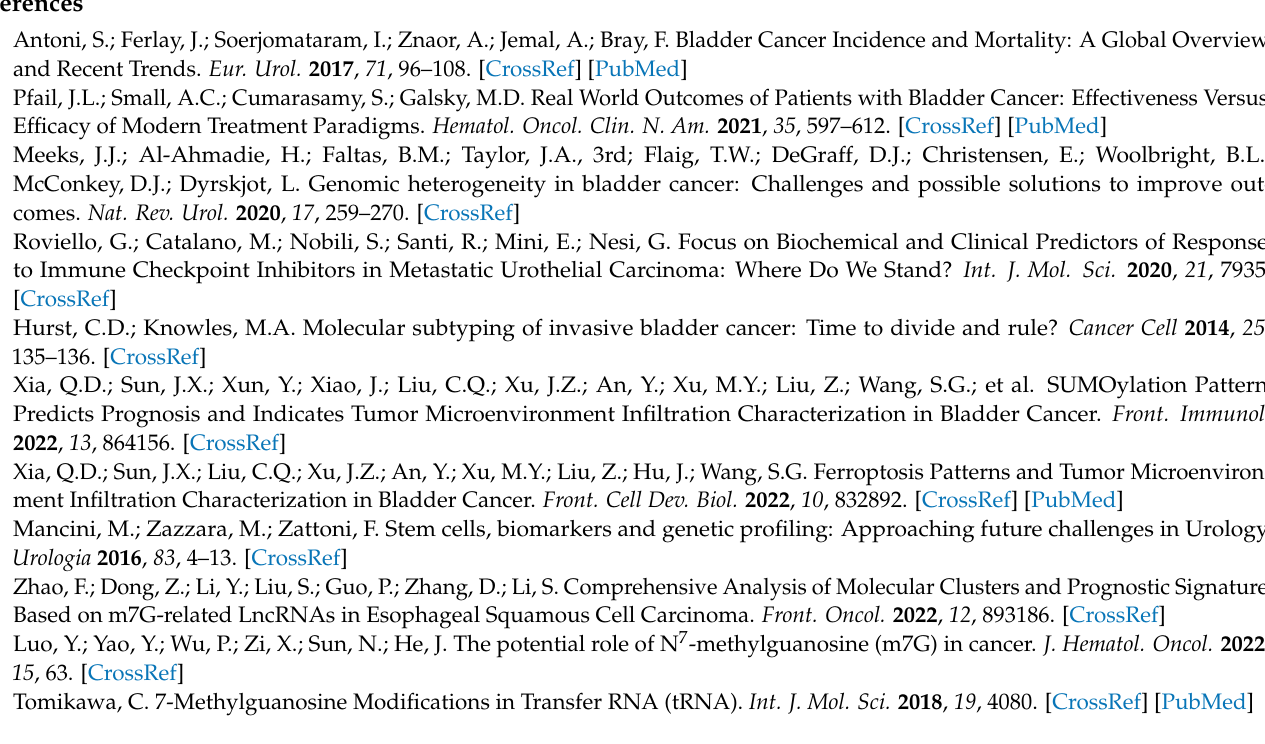
of 760 BLCA patients based on 1108 DEGs relevant to m7G-related clusters. Figure S3: Selection of Table S2: The results of consensus unsupervised clustering based on 18 m7G-related genes. Table S3: The result of differentially expressed analysis between cluster 1 and cluster 2. Table S4: The result of differentially expressed analysis between cluster 1 and cluster 3. Table S5: The result of differentially expressed analysis between cluster 2 and cluster 3. Table S6: The result of consensus unsupervised clustering analysis based on 1108 DEGs relevant to m7G-related clusters. Table S7: The result of univariate Cox analysis in gene signature A and B. Table S8: The result of LASSO analysis in gene signature A and